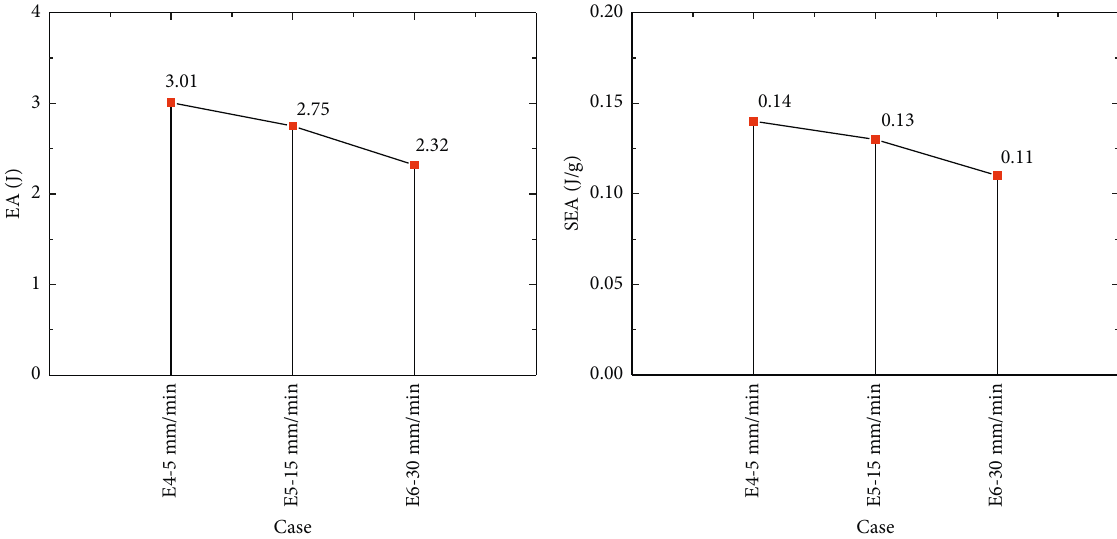
max , F avg , and CFE.